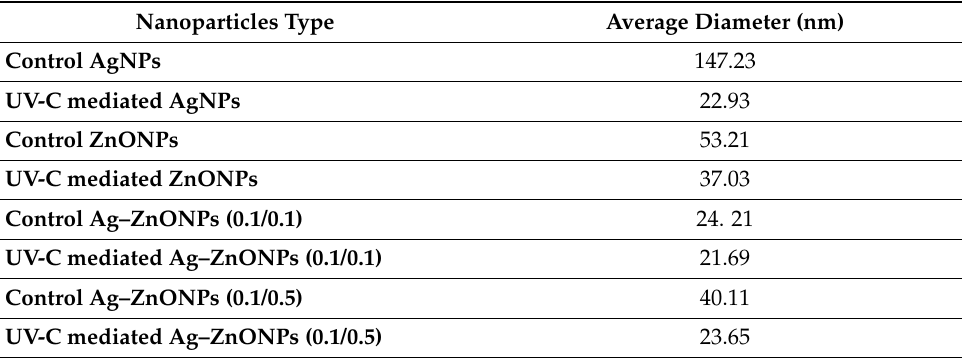
Figure 12. XRD pattern of bimetallic Ag–ZnONPs. ( A ) Control Ag–ZnO (0.1/0.1). ( B ) UV-C mediated Ag–ZnO (0.1/0.1). ( C ) Control Ag–ZnO (0.1/0.5). ( D ) UV-C mediated Ag–ZnO (0.1/0.5). Table 1. The average diameter of nanoparticles calculated using XRD data.